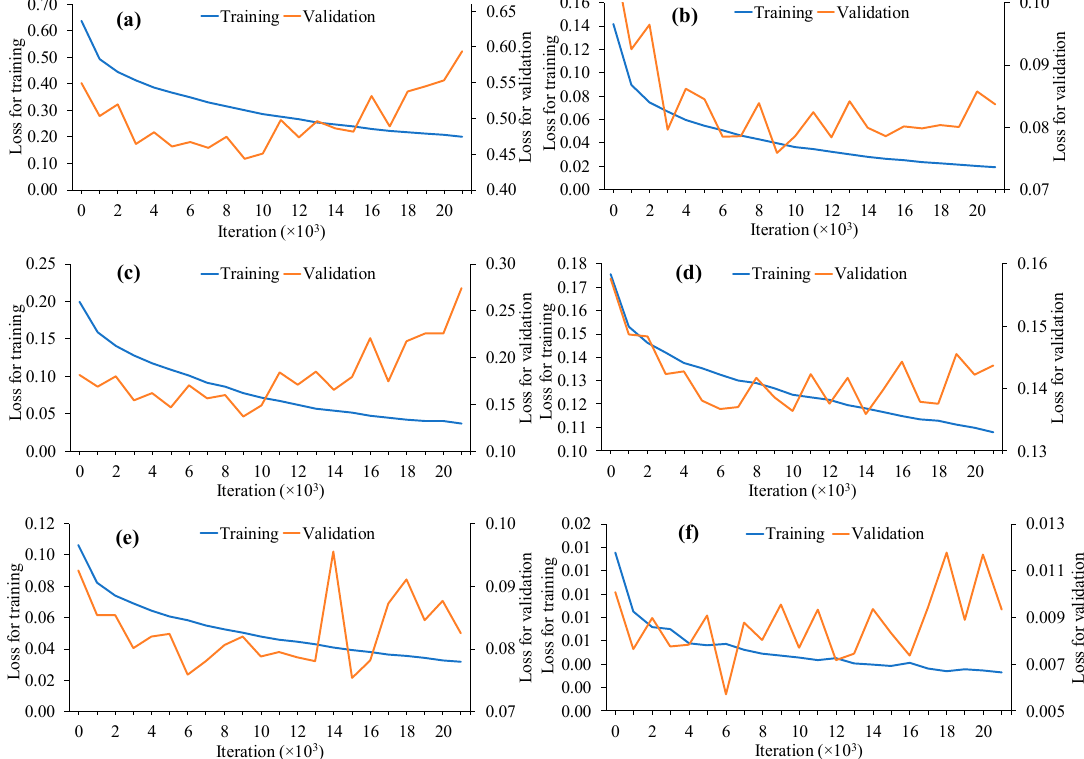
Figure 4. Samples of training and validation losses during training process. ( a ) Total loss; ( b ) detection head bounding box loss; ( c ) detection head class loss; ( d ) detection head mask loss; ( e ) region proposal network bounding box loss; and ( f ) region proposal network class loss.